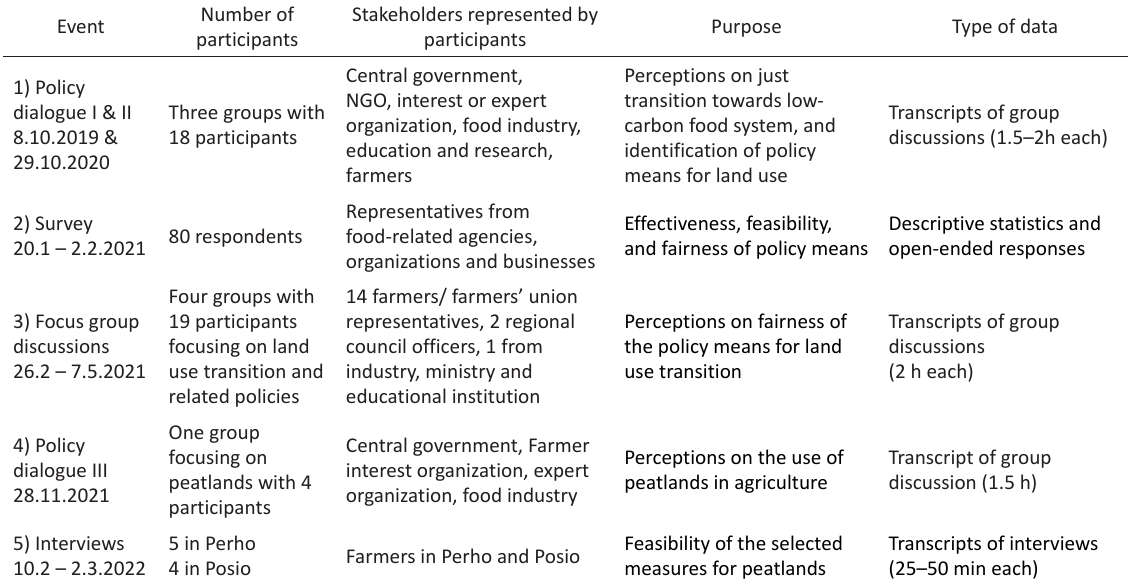
Table 1. The consequential steps for the qualitative method with the involvement of stakeholders from across the food system Number of Stakeholders represented by Event Purpose Type of participants participants